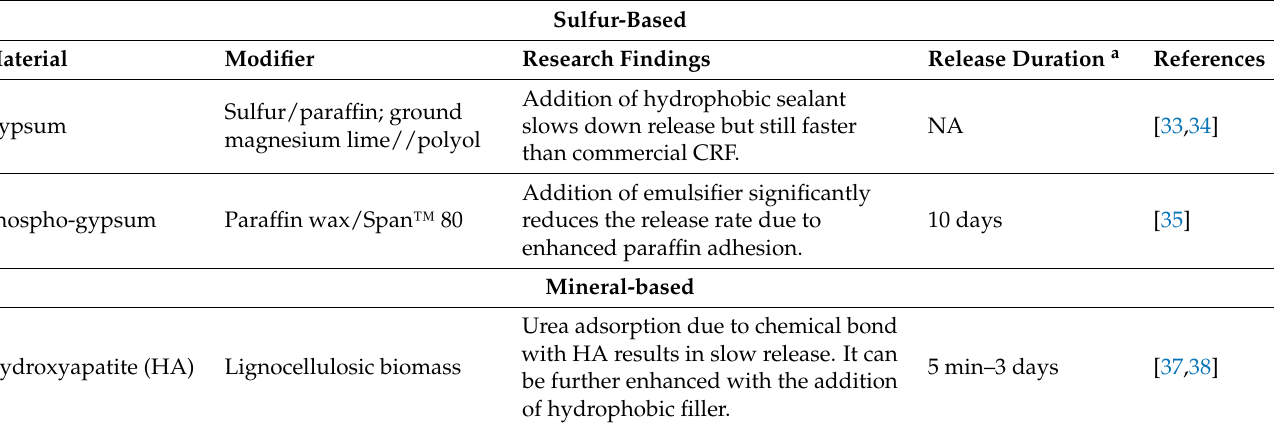
Table 1. Sulfur and mineral-based